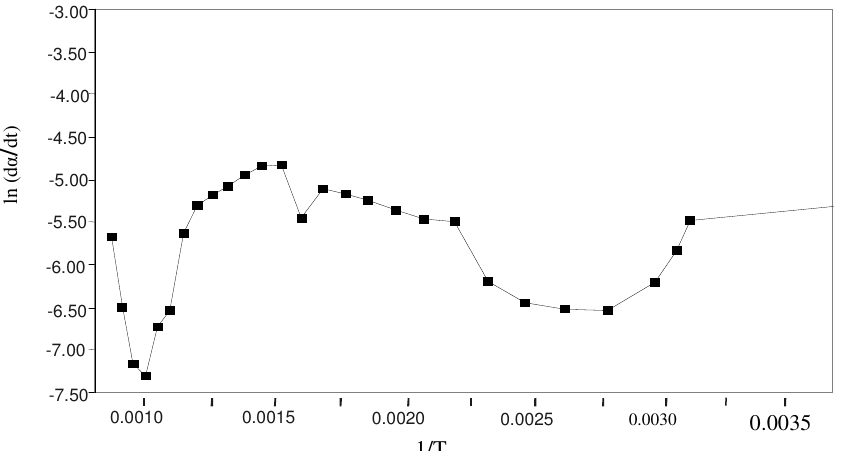
Figure 8. Freidman plot of p -CDF Terpolymer